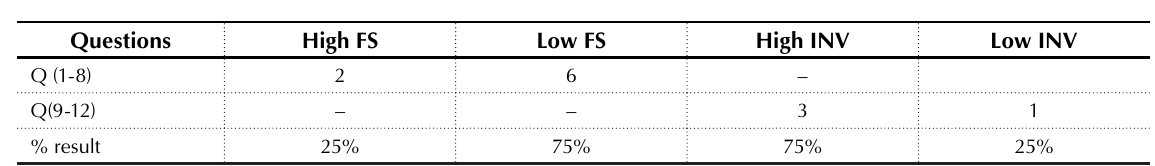
Table 5. Company